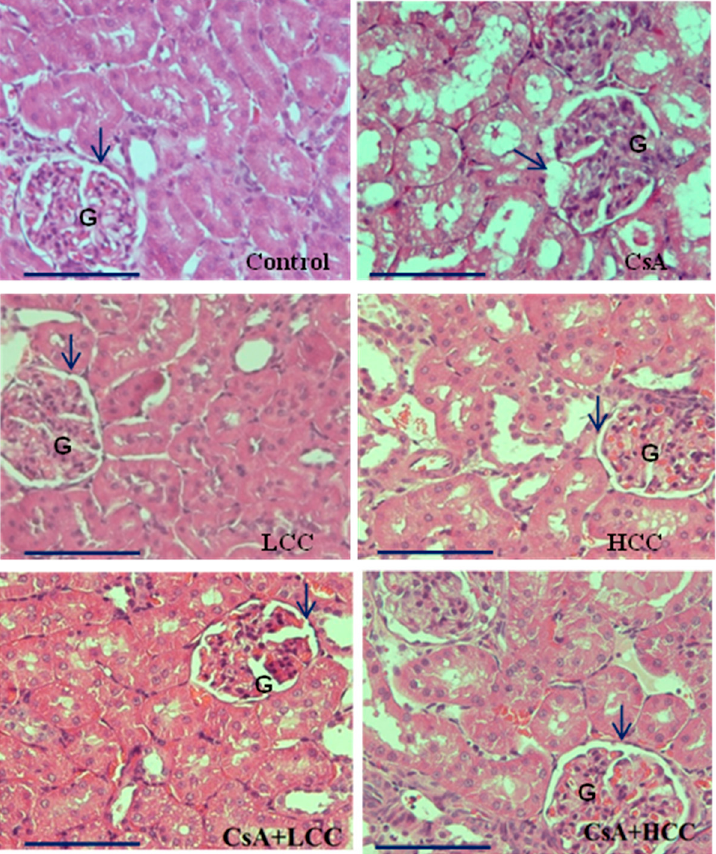
Figure 4. Representative photomicrographs of H&E stained sections in the renal cortex. Control group shows normal architecture of glomerulus (G) and the urinary space (arrow). CsA group shows disturbed architecture of renal cortex in a shrinkage pattern of the glomerulus (G) and widening of the urinary space (arrow). LCC (40 mg/kg) and HCC (400 mg/kg) groups present similar architecture of the renal cortex to that of control group with intact glomerulus (G) and urinary space (arrow). The CsA + LCC group displays partly preserved architecture of the glomerulus (G) and less widening of urinary space (arrow) than the CsA group. The CsA + HCC group displays further amelioration of the glomerulus (G) without shrinkage pattern and an intact urinary space (arrow). Magnification, 400× g (bar size 20 μ m).